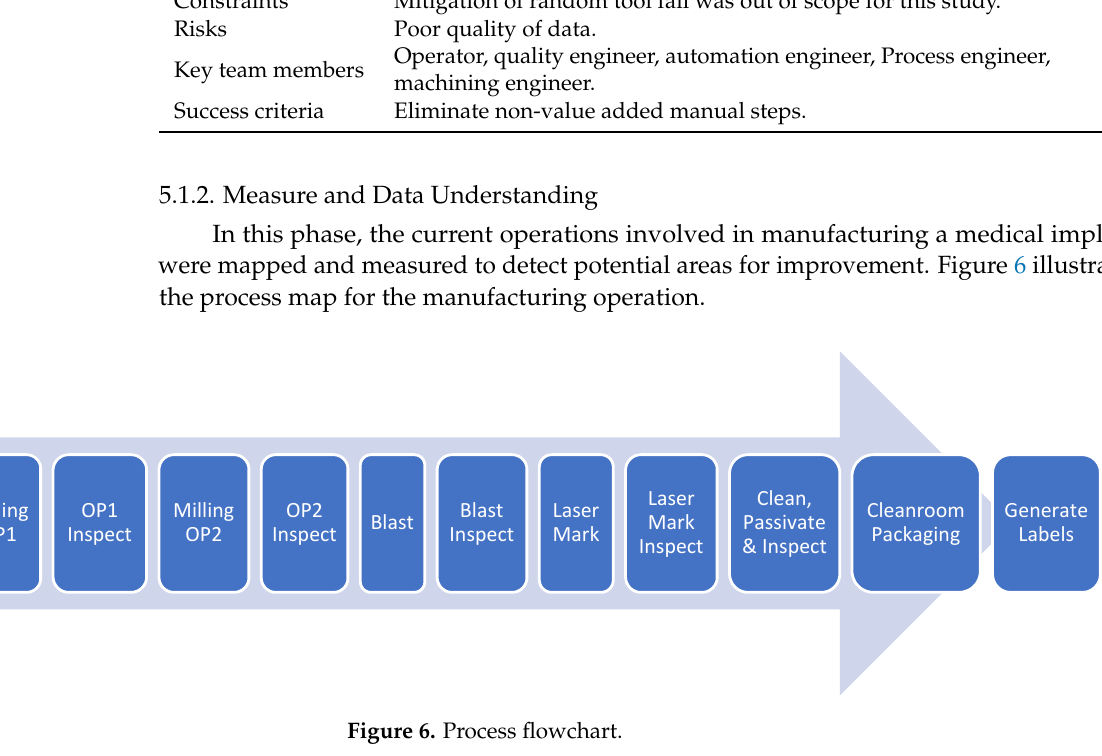
Figure 7. Pareto chart of operational scrap. Milling operation 2, which involved the CNC–CMM pair, had the highest percentage of scrap (36.96%). The total cycle time for this operation was 314 min/batch. The daily target output from this operation was 67 parts/day.